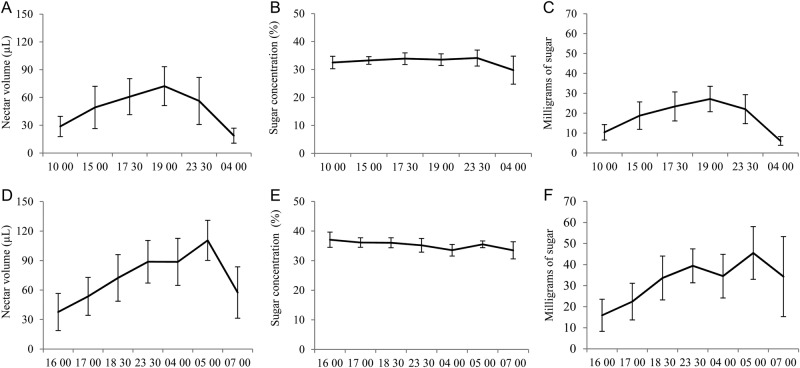
Nectar characteristics in diurnal and nocturnal periods of anthesis in flowers of two co-flowering Ipomoea in a Caatinga area, northeastern Brazil. (A) Volume, (B) concentration and (C) milligrams of sugar in Ipomoea marcellia flowers, (D) volume, (E) concentration and (F) milligrams of sugar in Ipomoea aff. marcellia. Horizontal lines join average values for each measurement time and bars indicate standard deviations. In both Ipomoea taxa values of n for volume, concentration and milligrams of sugar vary between 15 and 20 flowers per time point.